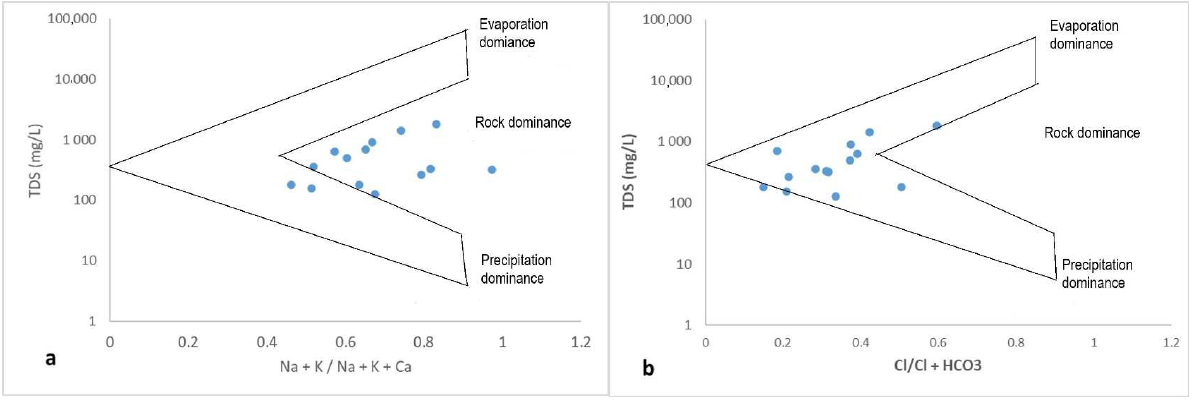
Figure 4. Gibbs diagram of the water samples collected in the Soutpansberg region where a and b are based on Equations (1) and (2) respectively.